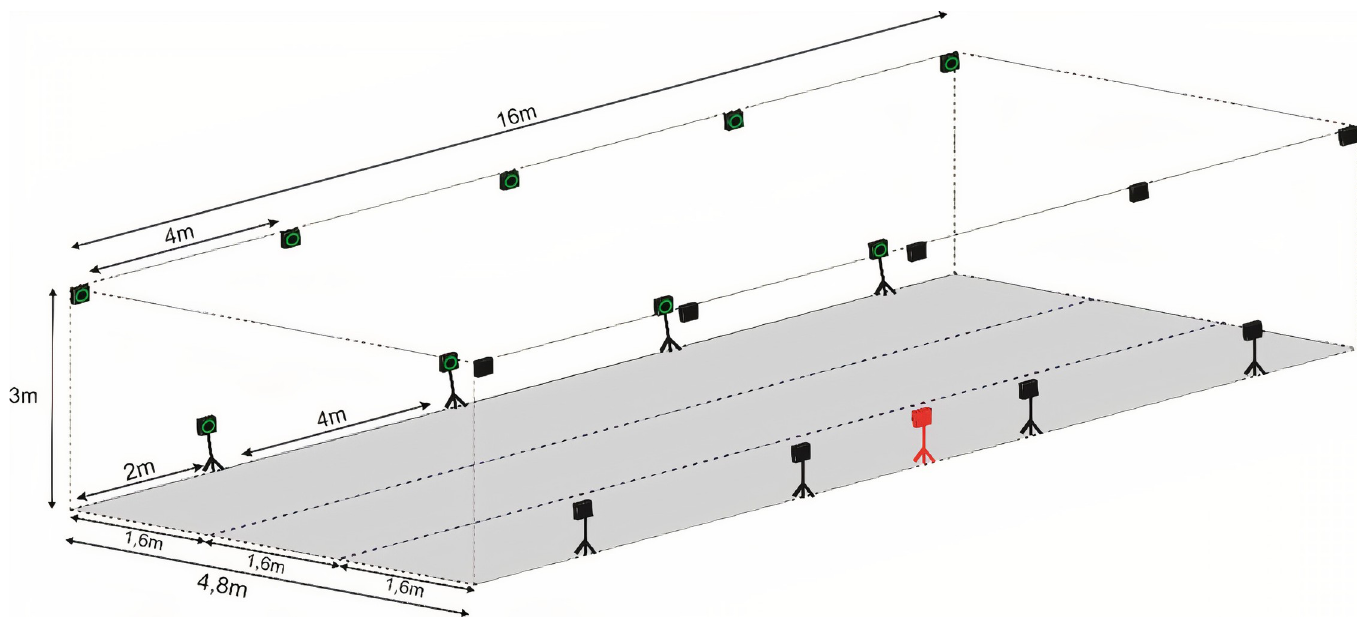
Fig 1. Schematic drawing of the cameras position (acquisition volume of 16 x 4.8 x 3 m 3 ). The dotted lines represent the path where the animals were led.